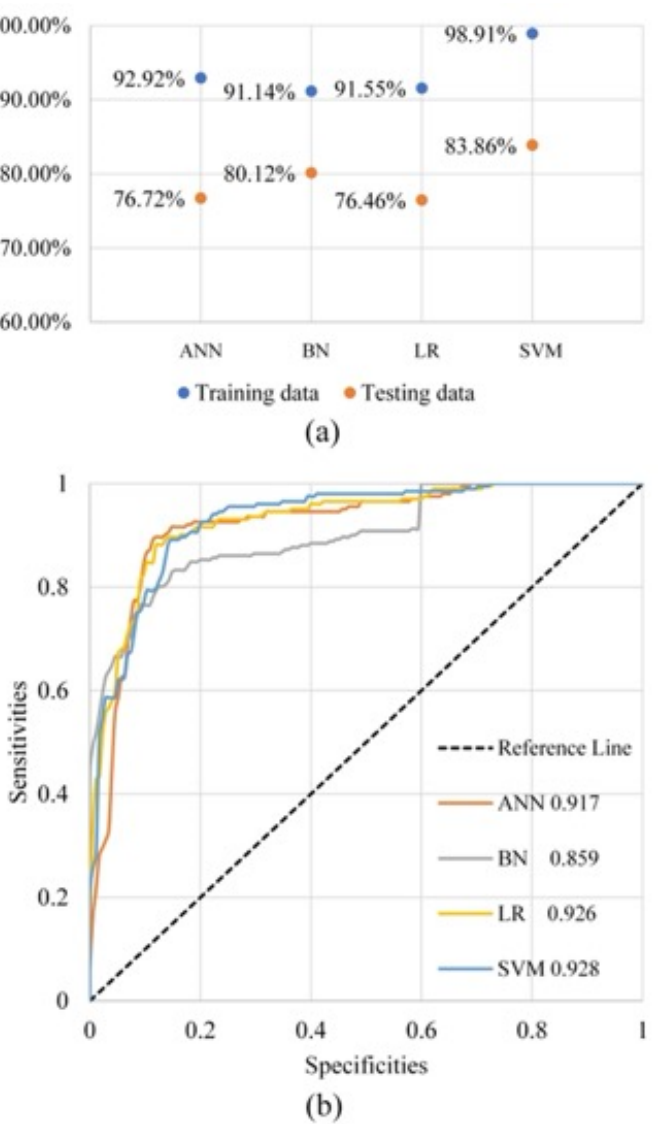
Figure 7. ( a ) The prediction accuracy of machine learning cluster with training data and testing data. ( b ) The receiver operator characteristics (ROC) curve of the machine learning cluster, AUC is the acronym of the area under the ROC curve. Table 2. The densities of landslide occurrence (SCAI) for ANN, BN, LR, and SVM models.